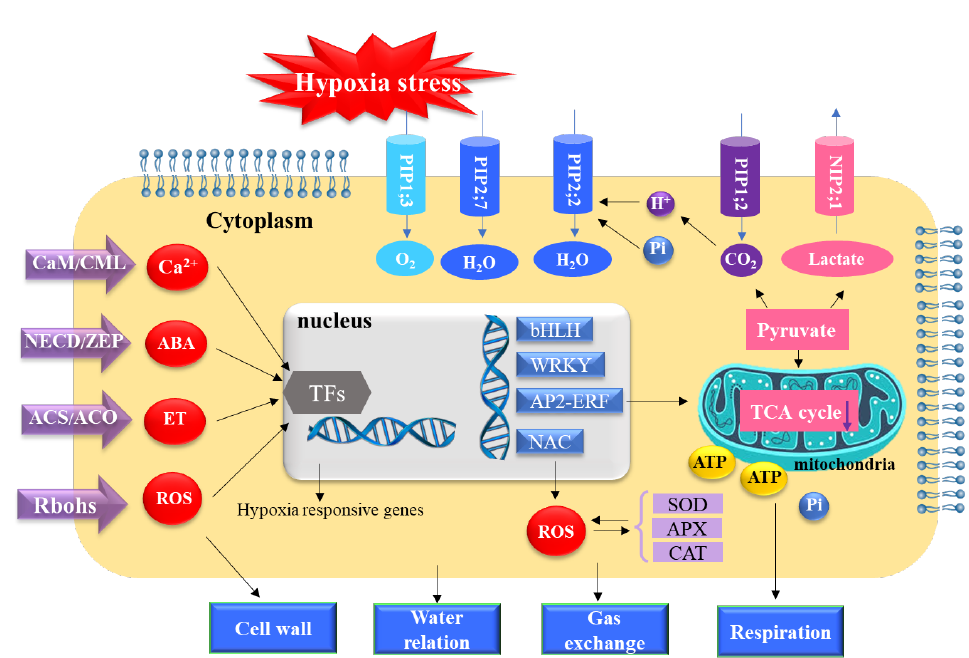
Figure 10. A model based on transcriptomic analysis for the responses of distal root tissues in canola to three days of root hypoxia. Hypoxia stress triggers alterations of cytosolic Ca 2+ , ABA, ethylene, and reactive oxygen species (ROS). Hypoxia-responsive signaling substances activated expression alteration of TF regulators including bHLH, AP2-ERF, WRKY, and NAC. The AP2-ERF expression was linked to downregulation of the TCA cycle, which resulted in ATP depletion leading to the energy crisis and affecting gas exchange and protein phosphorylation. As aerobic respiration was inhibited under hypoxia stress, fermentation activated NIP2;1 and PIP1;2 and helped with the efflux of lactic acid and CO 2 respectively. The NAC TFs were associated with generation of ROS, and ROS activated antioxidant systems involving SOD, APX, and POD. PIP1 ; 3 was upregulated, possibly to enhance the oxygen influx into the cytoplasm. The PIP2 ; 7 was upregulated to keep water homeostasis. Decreased pH and phosphorylation led to closure of water-transporting aquaporins, including PIP2 ; 2 , and led to decreases in L pr and, consequently, Ψ leaf . Increased ROS were associated with the cell wall modifications of root distal segments, gas exchange, and water relations of hypoxic canola plants.